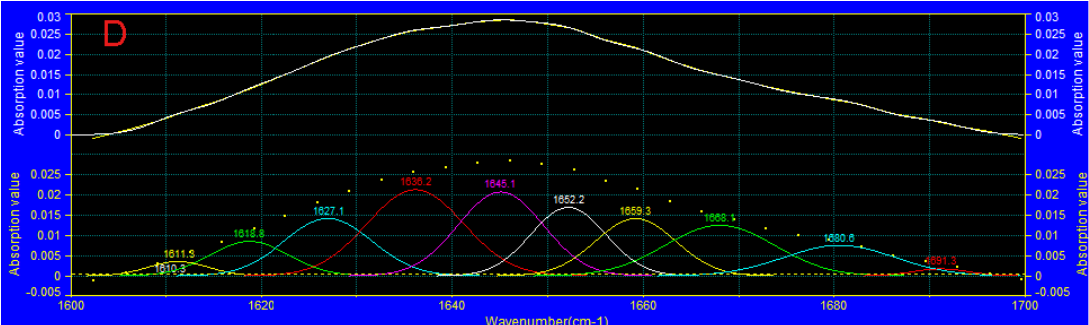
Figure 6. The second-order, second-derivative, mid-infrared spectra by PeakFit. ( A : 0 days; B : AP group on the 12th day; C : VP group on the 12th day; D : MAP group on the 12th day).